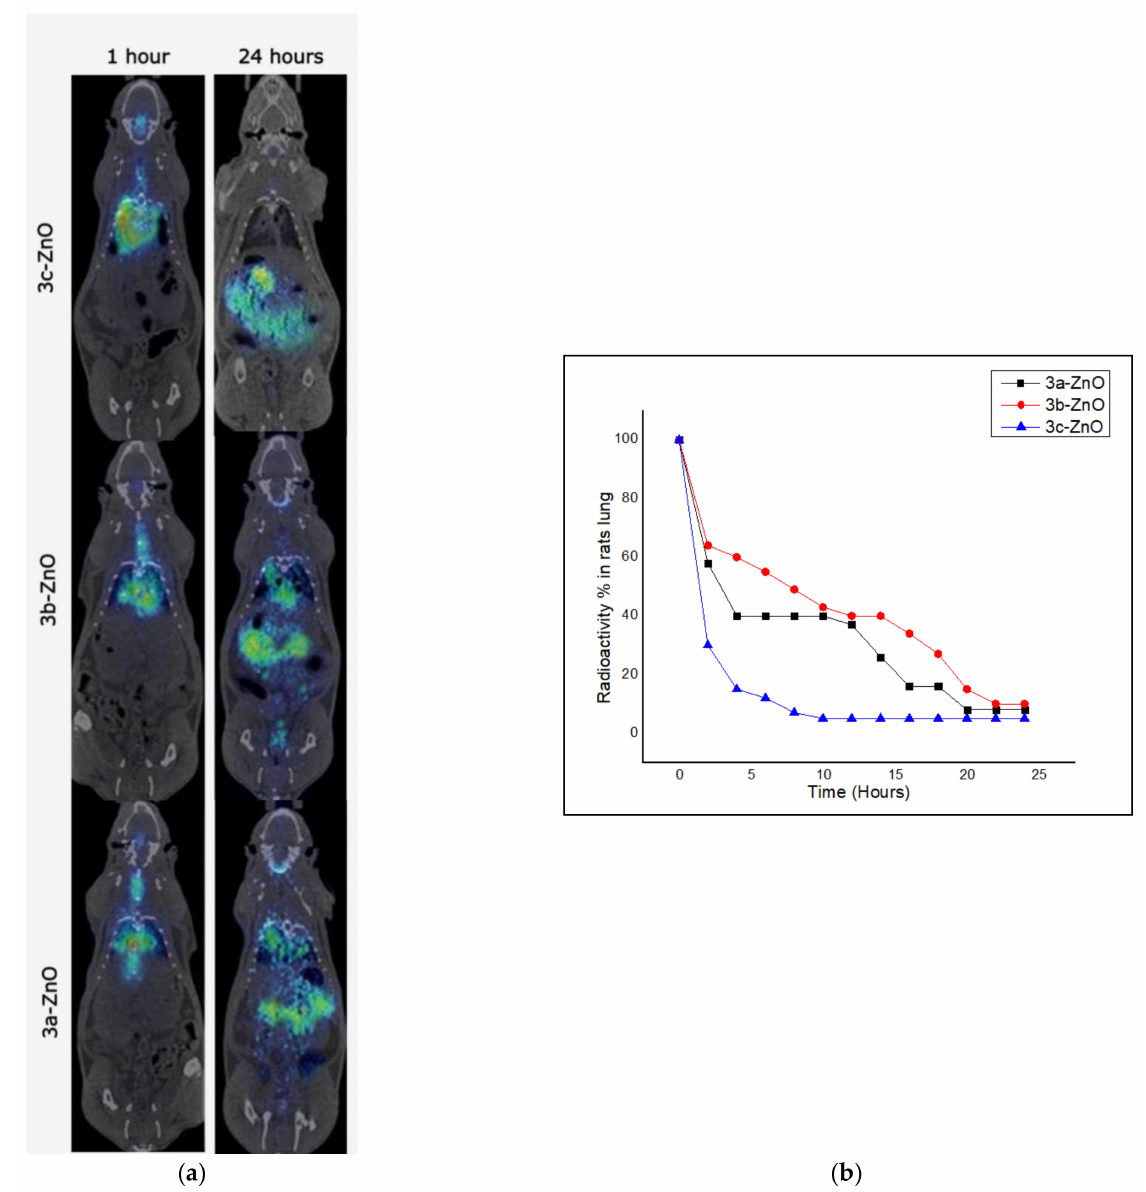
Figure 11. Endotracheal aerosolization in uninfected rats through PET-CT images of the biodistribu- tion of radiolabeled compounds ( a ). Concentration of the radiolabeled compounds in the uninfected rats’ lungs versus time ( b